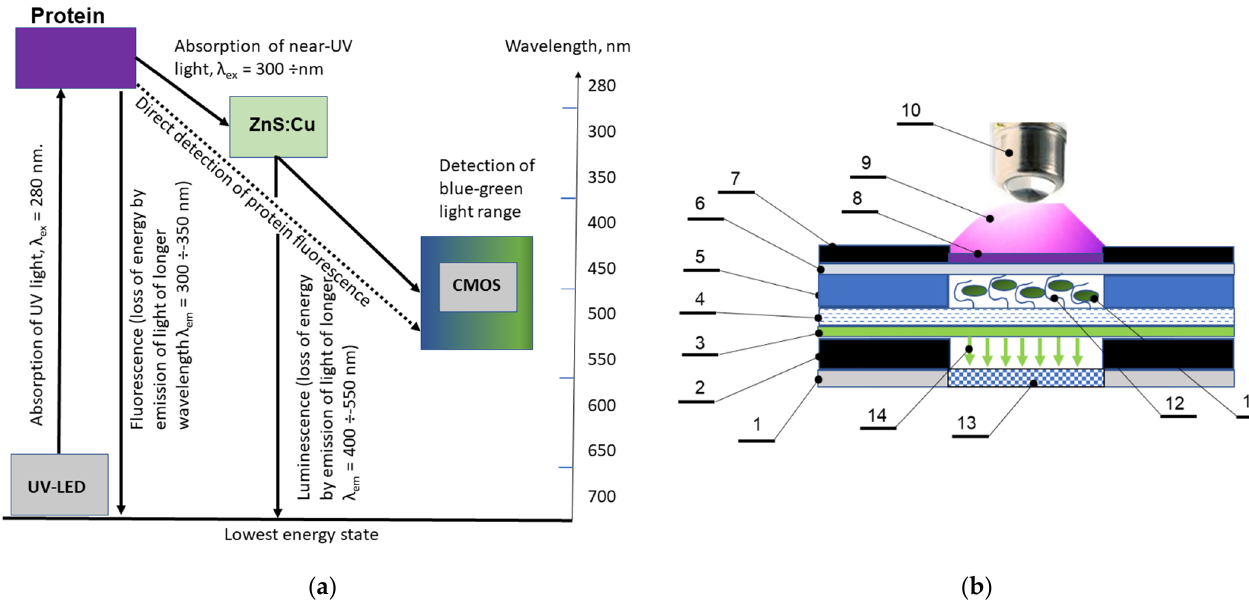
Figure 3. Schematic presentation of the sensing principle ( a ) and relevant optical setup ( b ) optical setup for fluorimetric analysis using a biosensor connected to a video camera. 1—casing of CMOS camera; 2—PMMA base (d = 1.5 mm); 3—luminophore layer, 4—glass filter and base of microfluidic channel (d = 0.2 mm); 5—Ordyl Alpha 350 dry film photoresist casing of biosensor with microfluidic system relief, (d = 0.05 mm); 6 –PP film, hermitization layer, and UV window (d = 40 µm); 7—PLA (d = 0.4 mm) outer casing of biosensor; 8—filter; 9—UV light; 10—UV LED; 11—protein marker; 12—aptamer; 13—CMOS-sensor; 14—generated luminescence.